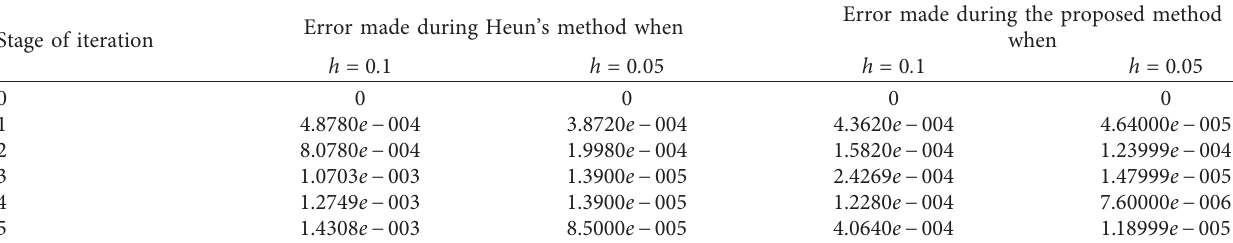
Table 4: Errors made by the stated numerical methods for Example 2.